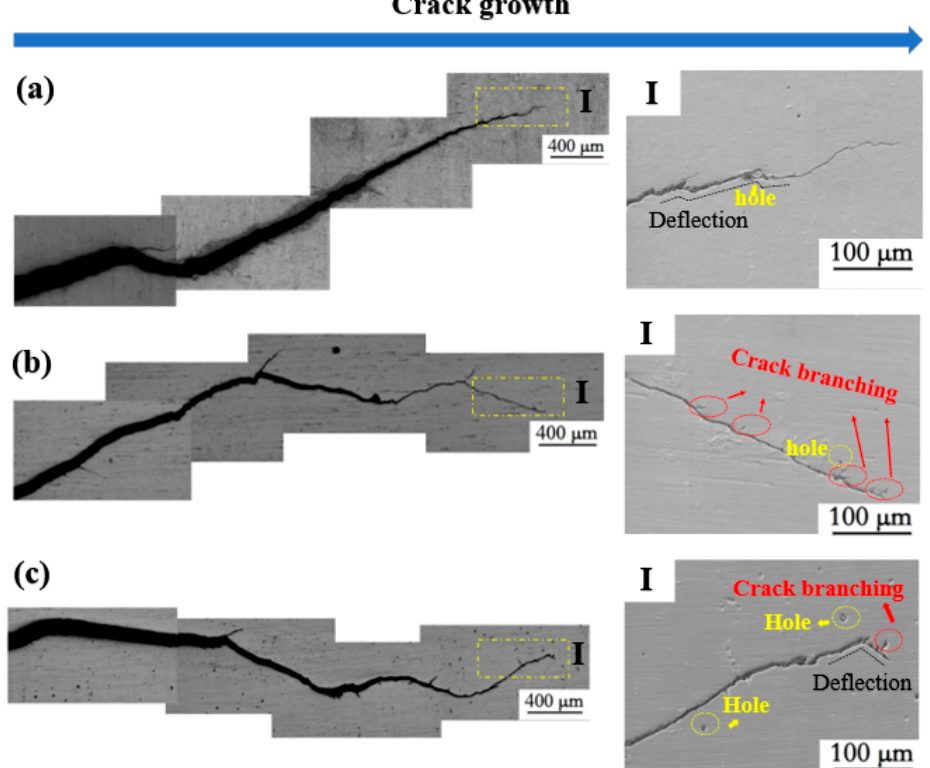
Figure 6. Corrosion fatigue crack propagation path of A7N01P-T4 aluminum alloy with different fatigue damage degrees: ( a ) P 0 , ( b ) P 1 , ( c ) P 2